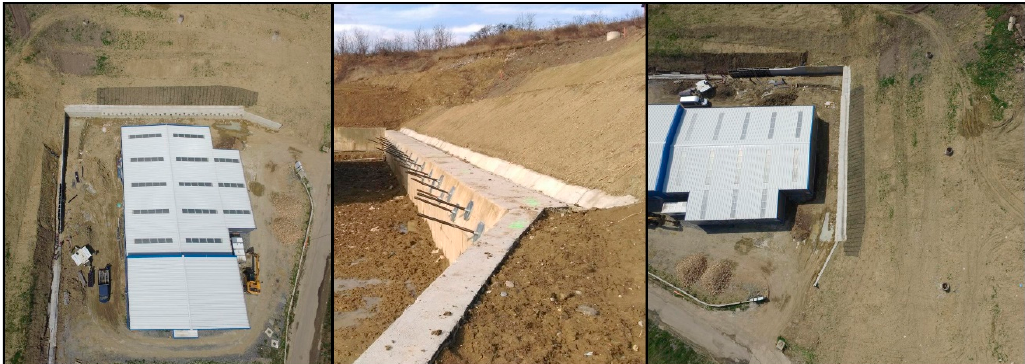
Figure 5. Collage of images depicting the newly constructed retaining wall and land improvement measures.